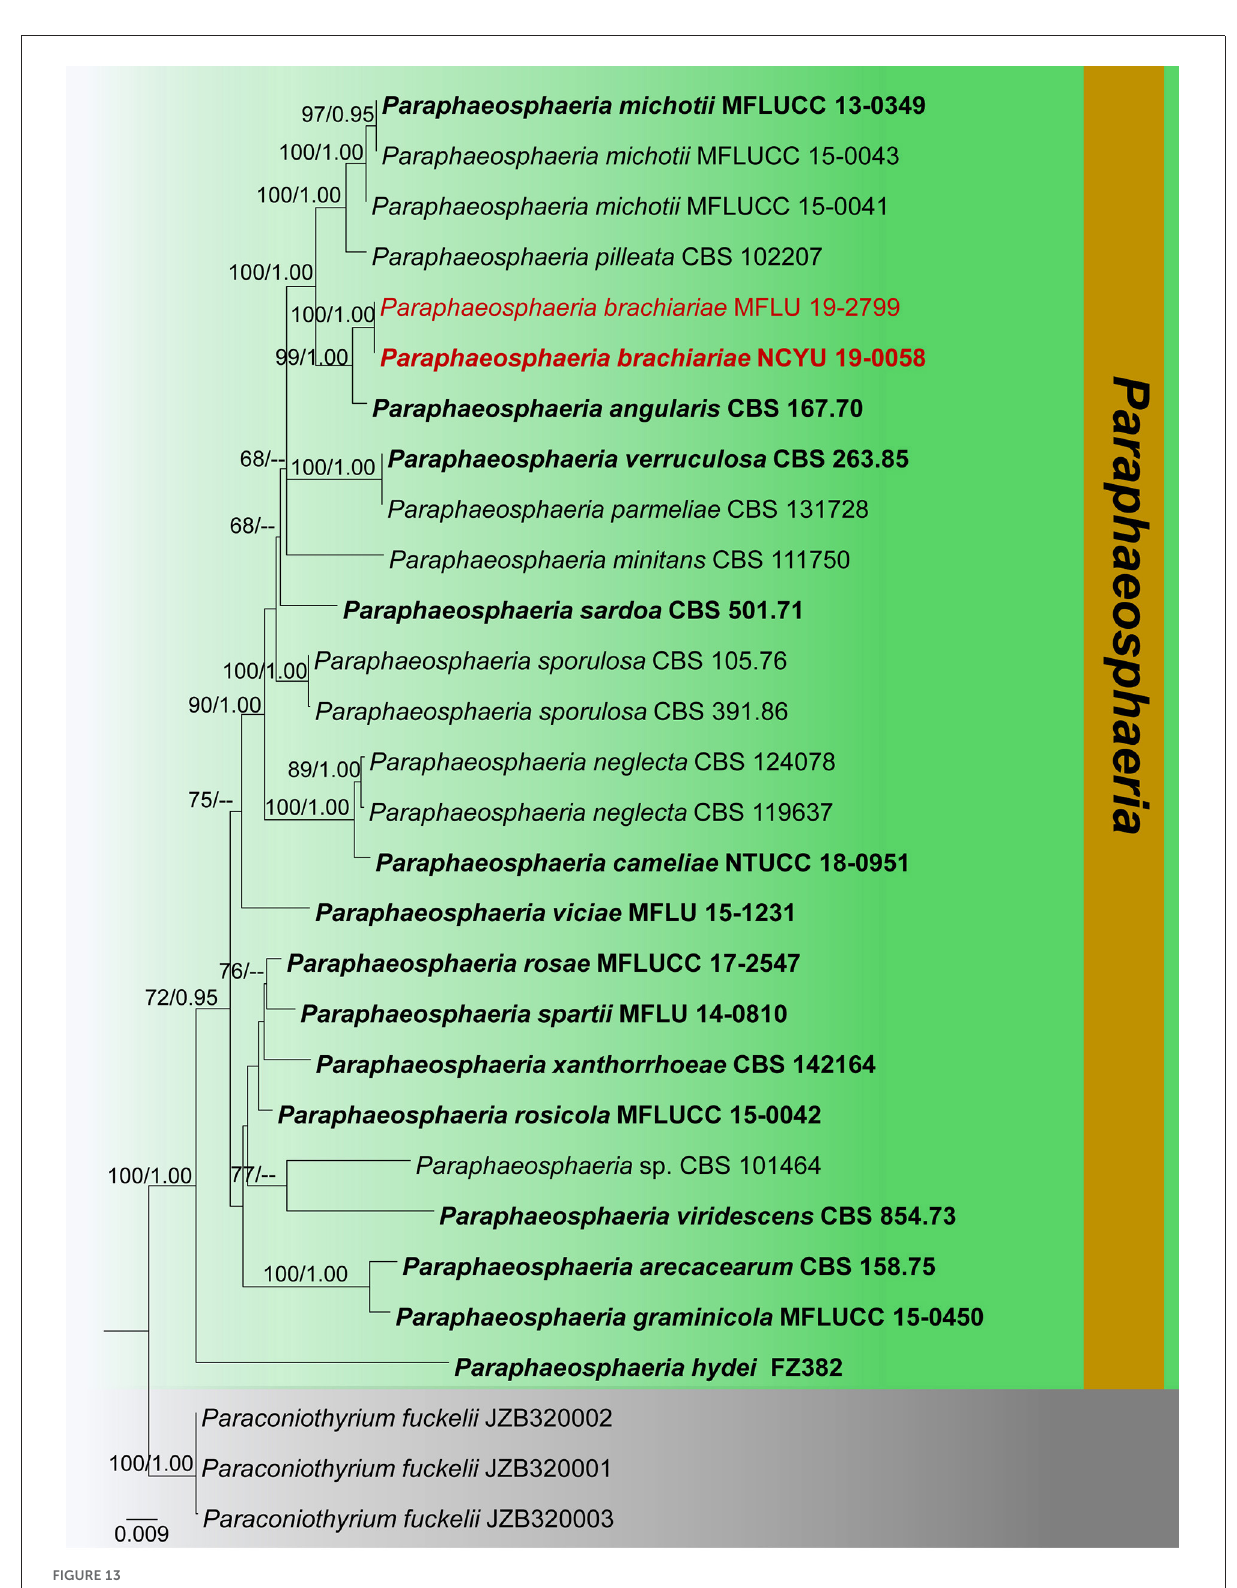
FIGURE13 Phylogram generated from maximum likelihood analysis is based on combined ITS, LSU, SSU, and tub2 sequence data (final likelihood value of − 9171.108559). The tree is rooted with Paraconiothyrium fuckelii (JZB320001, JZB320002, and JZB320003). The ex-type strains are indicated in bold, and the new isolates are indicated in red. Bootstrap support values ≥ 65% of maximum likelihood (ML) and Bayesian posterior probabilities (PP) values ≥ 0.90 are given above the